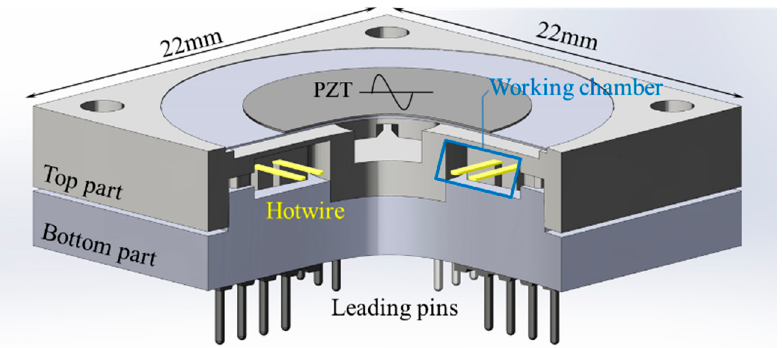
Figure 1. Cut view of a circulatory flow device. The device is completely sealed, and its internal flow in the working chamber is measured by the voltage on the implemented hotwire, through the leading pins.